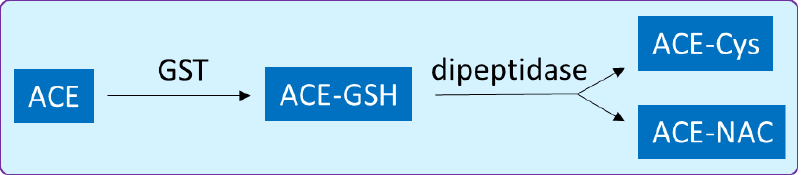
Figure 5. Biotransformation of acetaminophen (ACE) leading to formation of cysteine (Cys) and N-acetylcysteine (NAC) conjugates (adapted from Sun et al. [139] ).